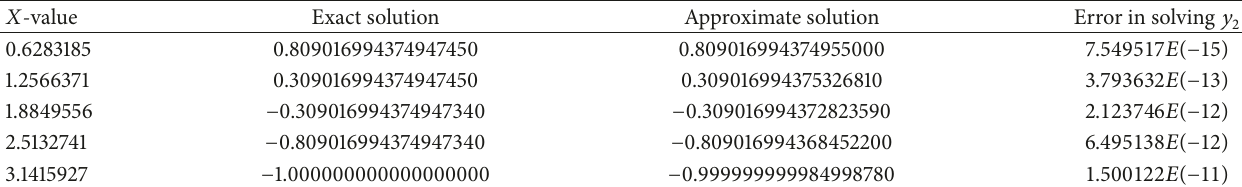
Table 10: Exact and approximate solutions for solving 𝑦 2 using the developed method. 𝑋 -value